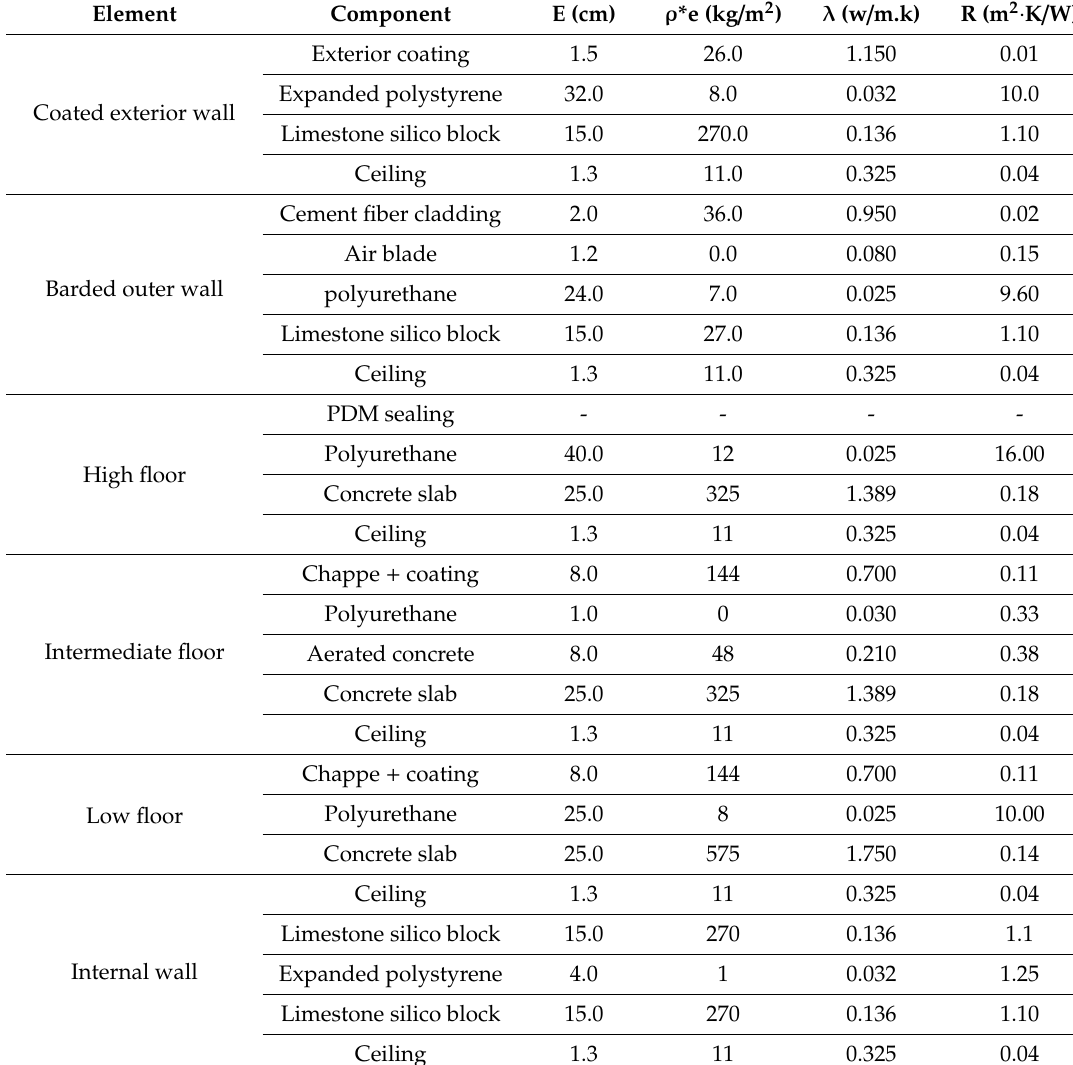
Table 1. Wall composition.